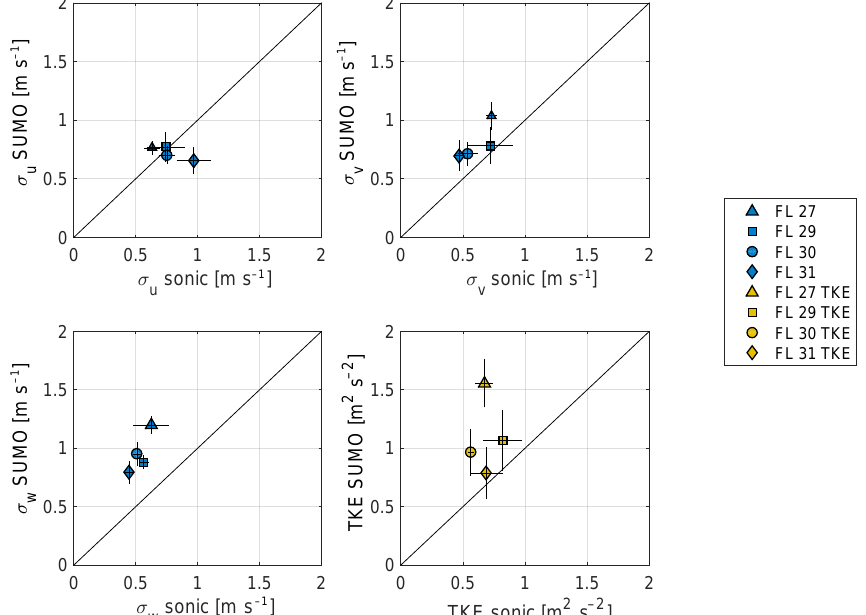
Figure 8. Mean standard deviations of u (upper left panel), v (upper right panel) and w (lower left panel) components of the wind, and mean TKE (lower right panel) from SUMO ( y axis) against the sonic anemometer from the 60m meteorological tower ( x axis), for flights no. 27 (triangle), no. 29 (square), no. 30 (circle) and no. 31 (diamond). The black bars show the variation between all the straight legs within each flight for all